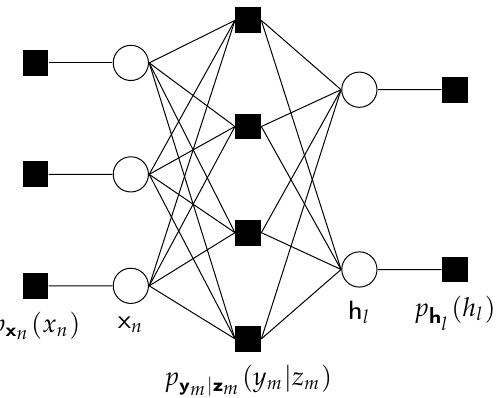
Figure 3. The factor graph for parametric generalized bilinear inference under N = 3, M = 4, and L =